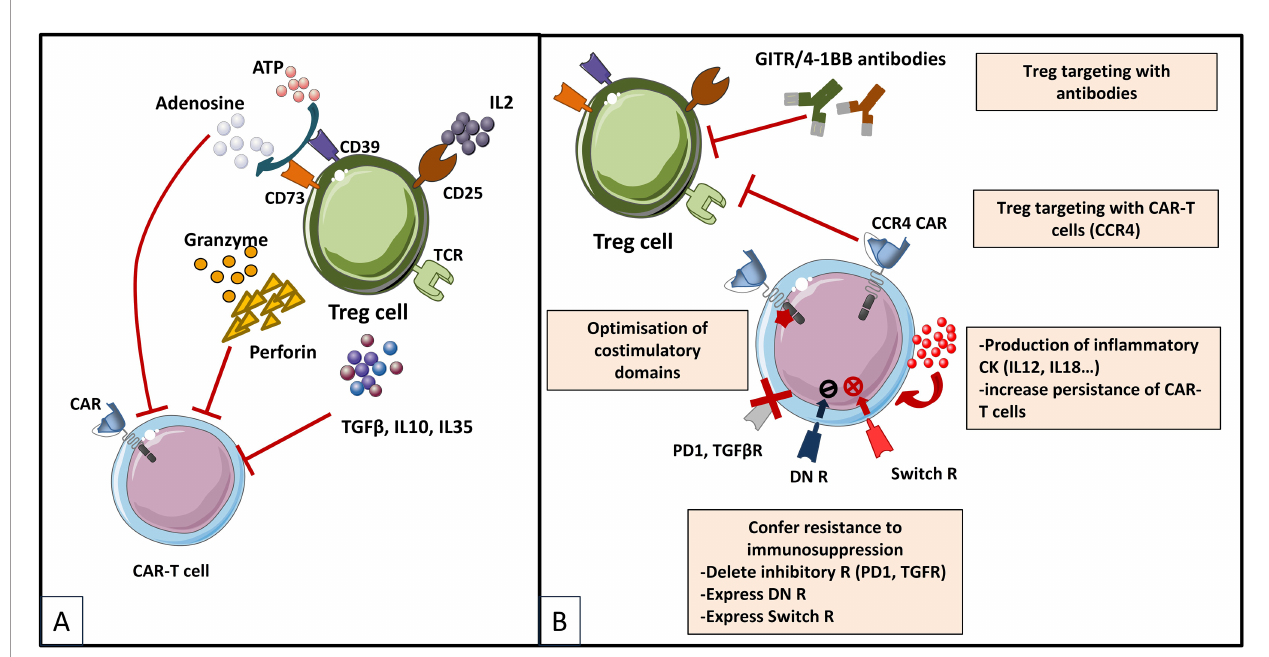
FIGURE 5 | Immunosuppressive mechanisms exerted by Tregs in the TME (A) and engineering strategies to surmount Treg-induced immunosuppression (B) [Adapted from Togashi et al. (212), and Rodriguez-Garcia et al. (213)]. (A) depicts mechanisms for regulatory T (Treg) cells immunosuppressive effects on CAR-T cells based on their physiologic roles. Tregs are immunosuppressive cells highly dependent on IL-2. They bind to and deplete IL-2 from their surroundings, thus reducing availability to effector T (Teff) cells by constitutively expressing the high af fi nity IL-2 receptor (IL2R) subunit- a (CD25). Treg cells also produce immunosuppressive cytokines (IL-10, IL-35 and TGF b ), which can downregulate the activity of both Teffs and antigen presenting cells (APCs) and they exert direct cytotoxic effects by secreting granzymes and perforin. Moreover, Treg cells release large amounts of ATP, which is converted to adenosine (by CD39 and CD73) that can provide immunosuppressive signals to Teff cells and APCs. Other indirect mechanisms not depicted in the fi gure by which Tregs exert immunosuppressive effects are mediated by APC, as for instance Tregs expression of cytotoxic T lymphocyte antigen 4 (CTLA-4), which binds to CD80/CD86 on APCs, thereby transmitting suppressive signals to these cells and reducing their capacity to activate Teff cells. (B) shows therapeutic strategies to overcome the immunosuppressive TME sustained by Tregs. Some strategies are based on elimination of Tregs by CAR-T cells or combinations of CAR-T cells with monoclonal antibodies (mAbs) or drugs. CAR-T cells have been designed to target antigens expressed by Tregs for direct depletion. Other strategies are based on immunomodulation of the TME in order to increase CAR-T cells performance: 1) expression of proin fl ammatory cytokines by CAR-T cells and 2) optimization of costimulatory signaling domains in order to reduce IL-2 secretion and impair Treg expansion and tumor in fi ltration. Last type of strategies are meant to confer an intrinsic resistance to immunosuppression to CAR-T cells, either by endowing them with 1) dominant-negative receptors (DN R) meant to disrupt signaling, or 2) a chimeric switch receptor (CSR or Switch R) to convert negative signaling into a positive one, or by abrogating the expression of inhibitory receptors (like PD1 of TGF b receptors) using genome-editing tools (knock